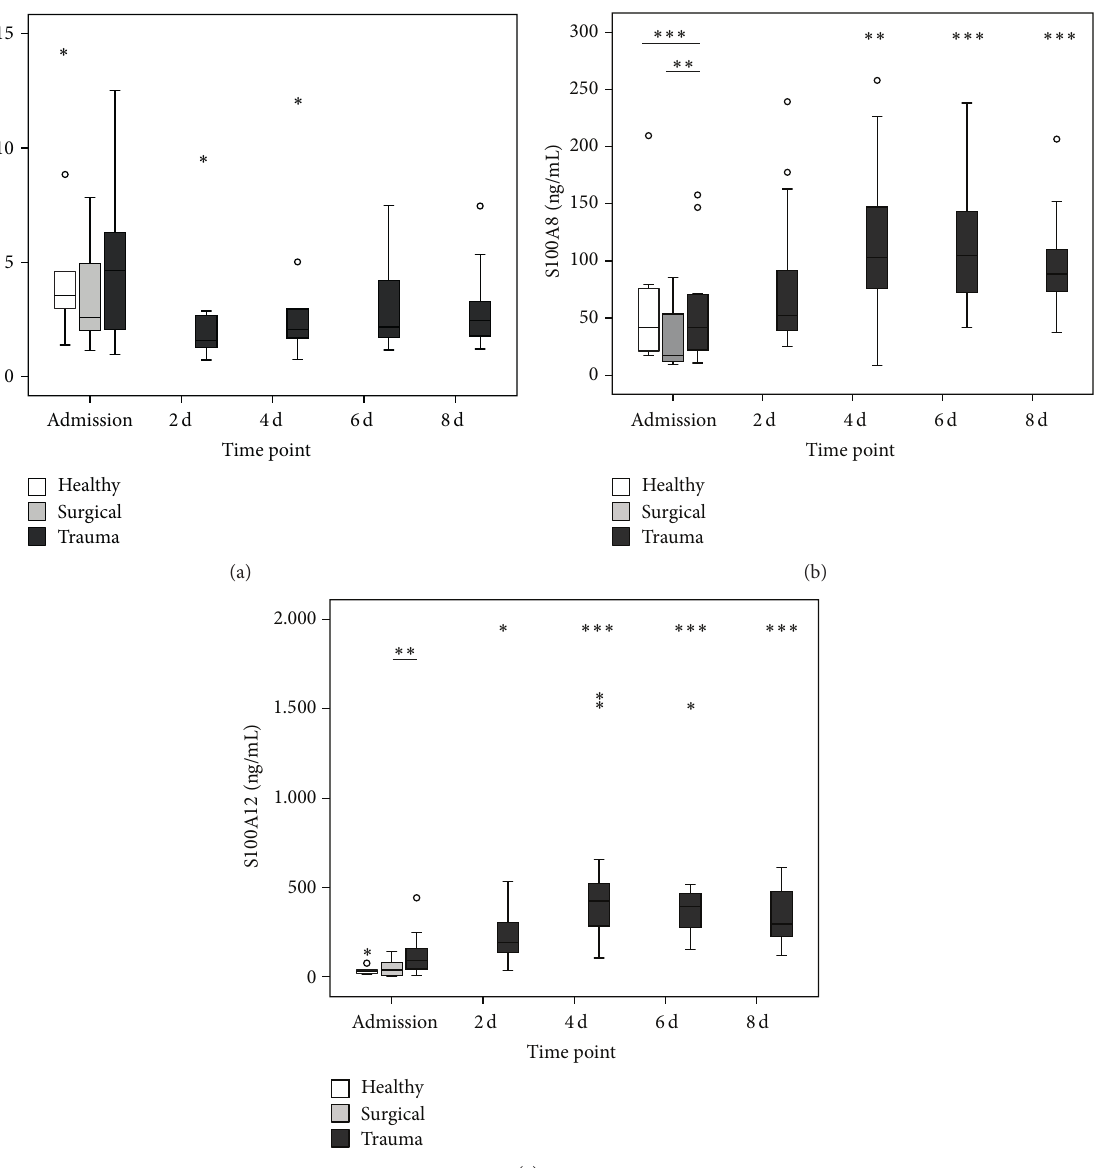
Figure 3: Plasma concentrations of proteinergic RAGE ligands after trauma. HMGB1 (a), S100A8 (b), and S100A12 (c) levels at admission ( 𝑛 = 16 /10/10 for trauma/surgical/healthy) and 2 d ( 𝑛 = 16 ), 4d ( 𝑛 = 15 ), 6d ( 𝑛 = 11 ), and 8 d after trauma ( 𝑛 = 11 ). ∗ 𝑃 < 0.05 , ∗∗ 𝑃 < 0.01 , and ∗∗∗ 𝑃 < 0.001 compared to trauma at admission (Mann-Whitney 𝑈